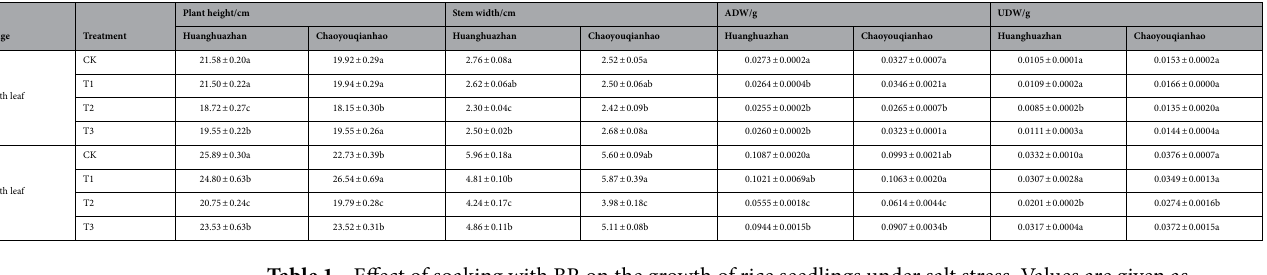
Table 1. Effect of soaking with BR on the growth of rice seedlings under salt stress. Values are given as means ± SE and different lowercase letters indicate significant differences at the P < 0.05 level. CK: soaking with distilled water + watering 0 g L −1 NaCl. T1: soaking with BR + watering 0 g L −1 NaCl. T2: soaking with distilled water + watering 3 g L −1 NaCl. T3: soaking with BR + watering 3 g L −1 NaCl. ADW aboveground dry weight, UDW underground dry weight.